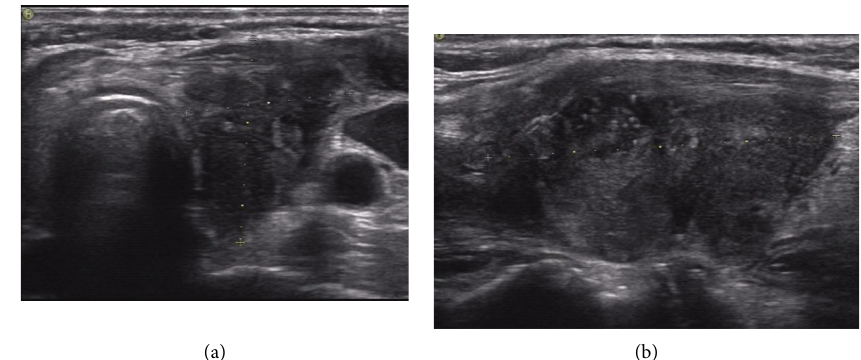
Figure 1: Papillary thyroid carcinoma with central lymph node metastasis. The tumor is located in the middle and lower poles of the left thyroid lobe. The maximum diameter is 40mm. It is solid and very hypoechoic with an aspect ratio < 1, external invasion, internal visible hyperechoic small calcification, and American College of Radiology Thyroid Imaging Reporting and Data System (ACT TI-RADS) score of 11 points. (a) Transverse section and (b) longitudinal